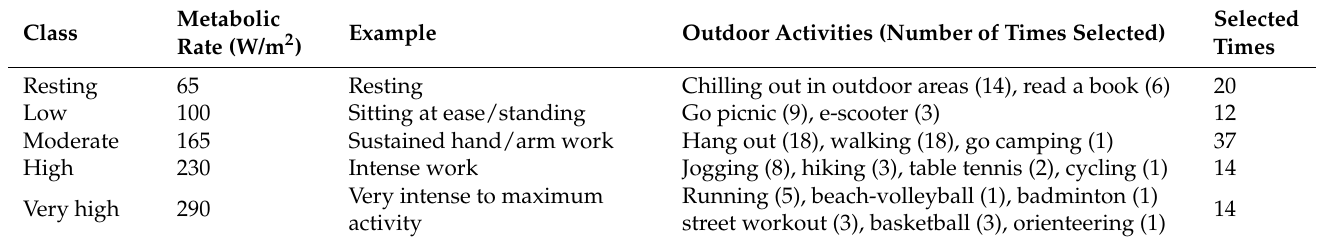
Table 6. Classification of metabolic rates by activity developed in the Taltech campus